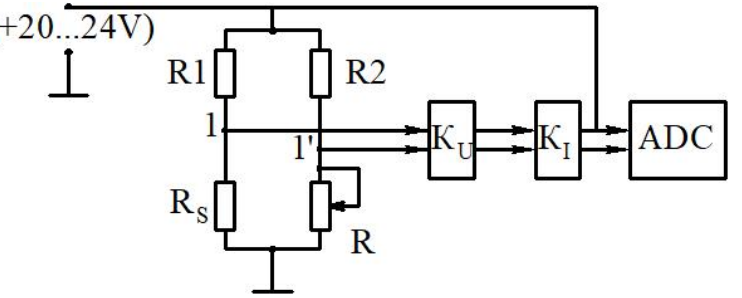
Figure 16. Schematic diagram of the connection of the hot-wire anemometer sensor to the power supply: ADC—analog-to-digital converter; K U and K I —voltage and current amplifiers, respectively; R, R1, R2—bridge electrical resistances, R S —sensor resistance.